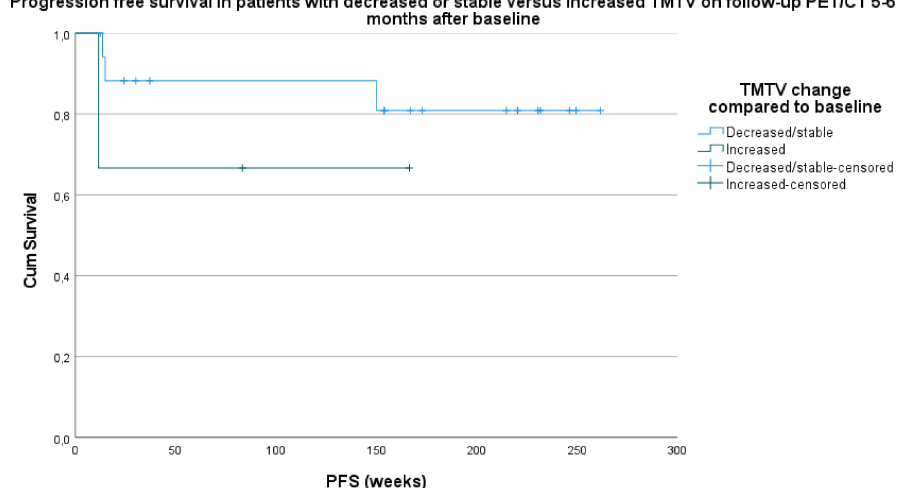
Figure 4. Survival analysis based on progressive free survival (PFS) in patients with stable/decrease in TMTV versus increase in TMTV on follow-up PET/CT 5–6 months after baseline compared to TMTV on baseline PET/CT.